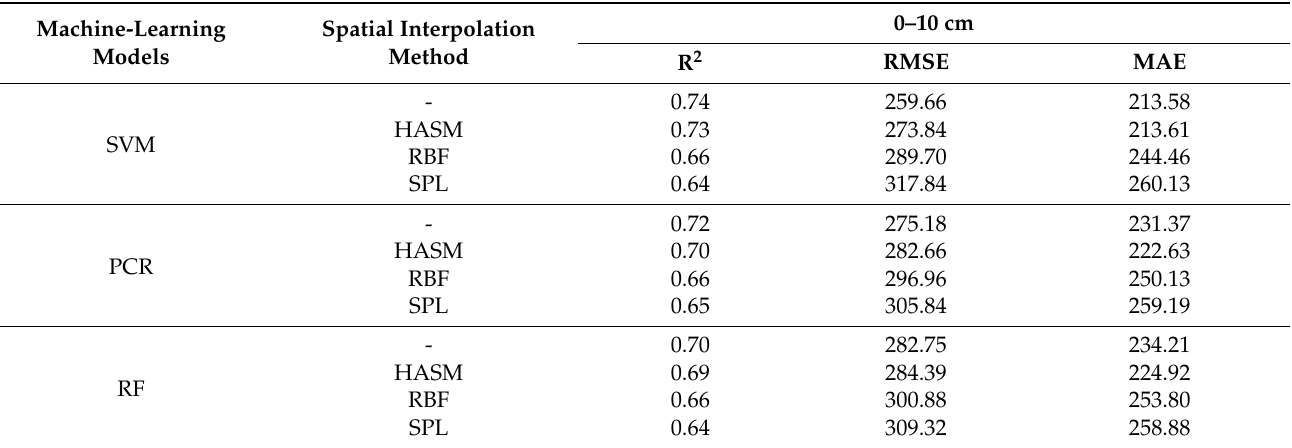
Table 3. Accuracy of different combinations of estimation models and spatial interpolation methods for mapping of grassland root biomass in the 0–10 cm soil layer in Altay Prefecture,